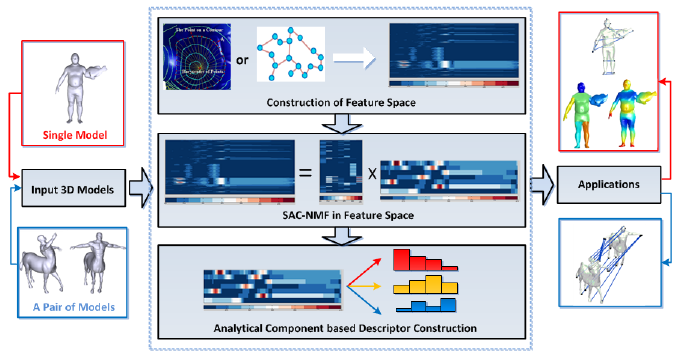
Figure 1. The illustration of our framework, with the light blue rectangles denoting the main parts. The input models can be either one single model or a pair of models, and the output application results mainly include symmetry and saliency detection, segmentation, and